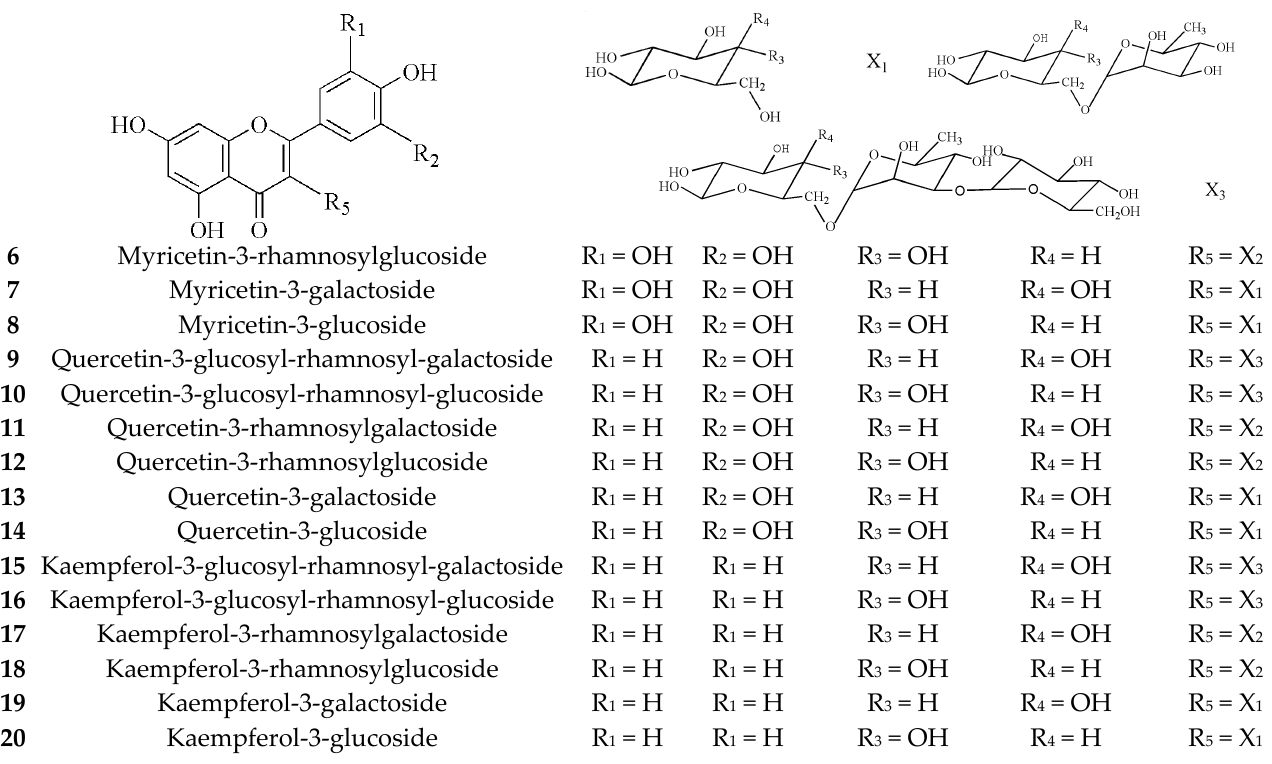
Figure 1. Chemical structures of catechins isolated from green tea.